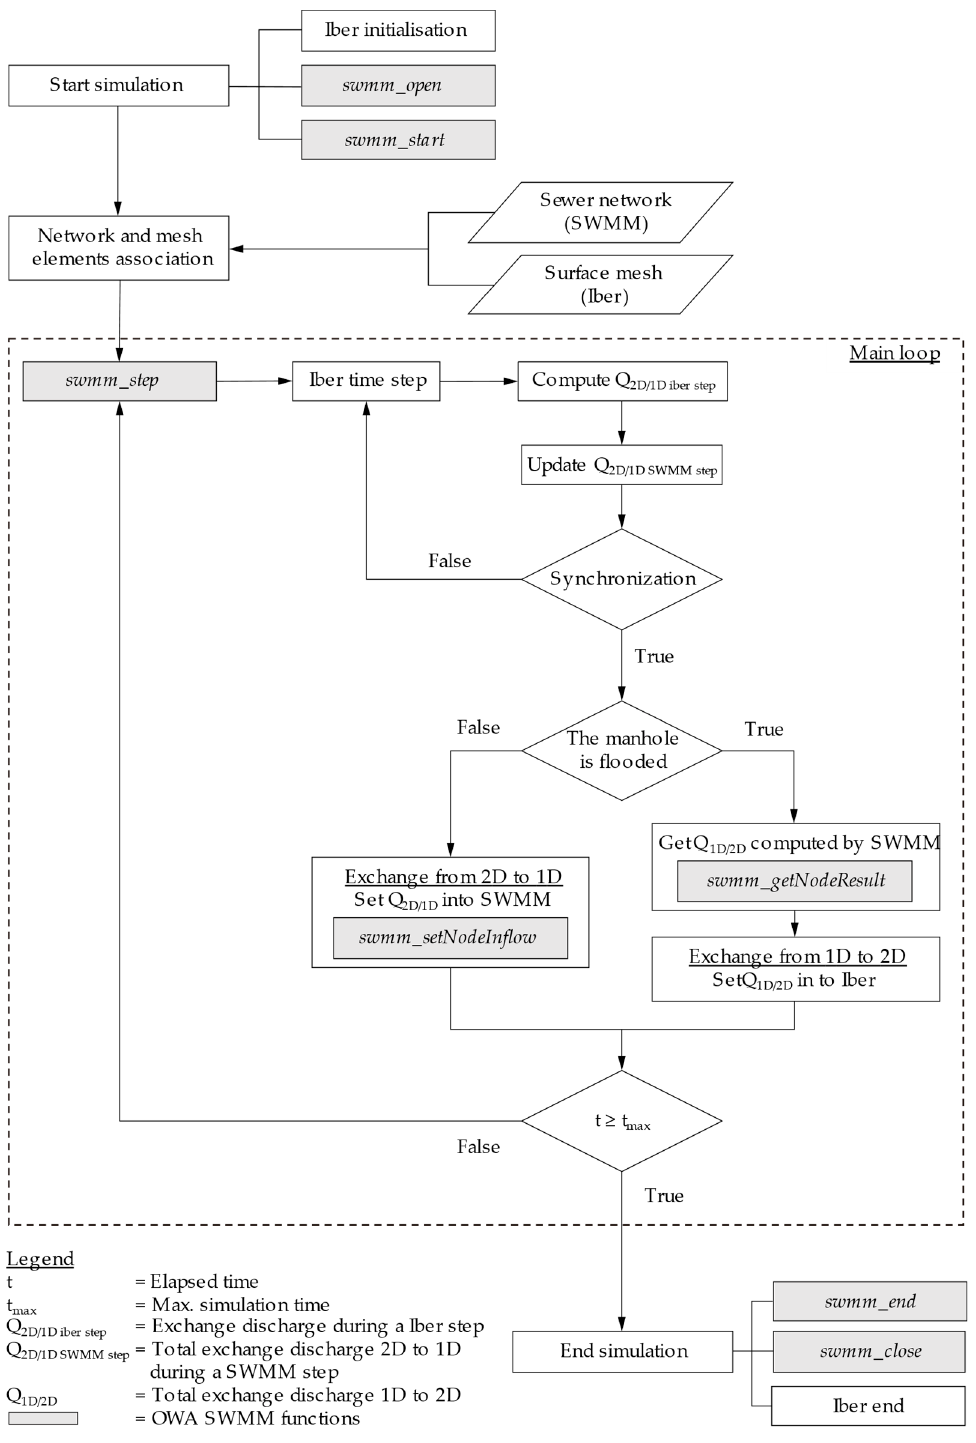
Figure 1. Flow diagram of the 1D/2D urban drainage model.